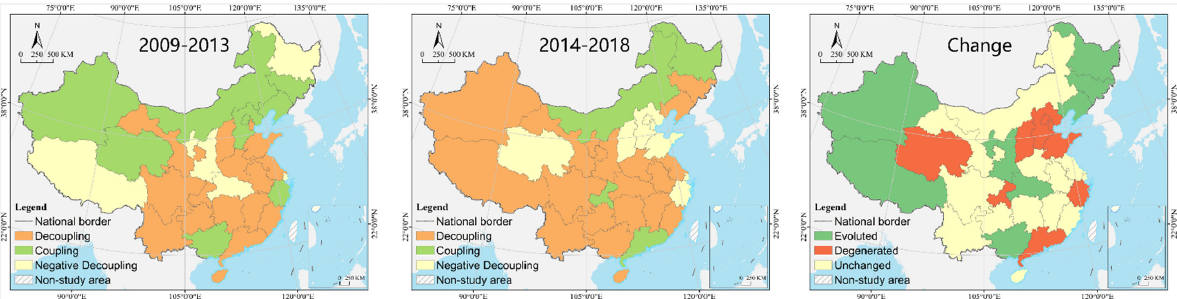
Figure 9. Analysis on the three types of decoupling relationships in total